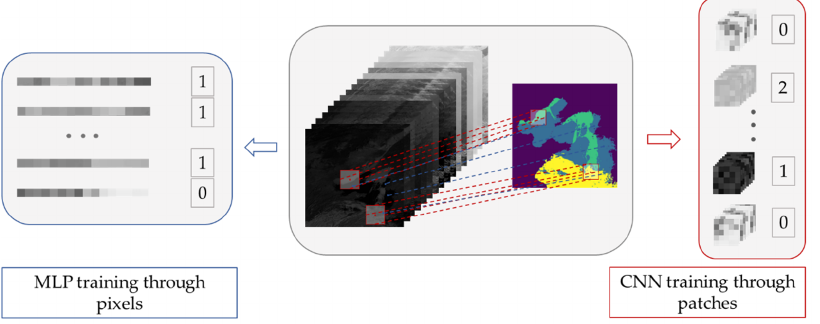
Figure 2. The extraction procedure of the samples and corresponding labels for the MLP and CNN model. The sea fog, clear sky, cloud pixels are indicated in green, blue and yellow, respectively in the middle of the panel.